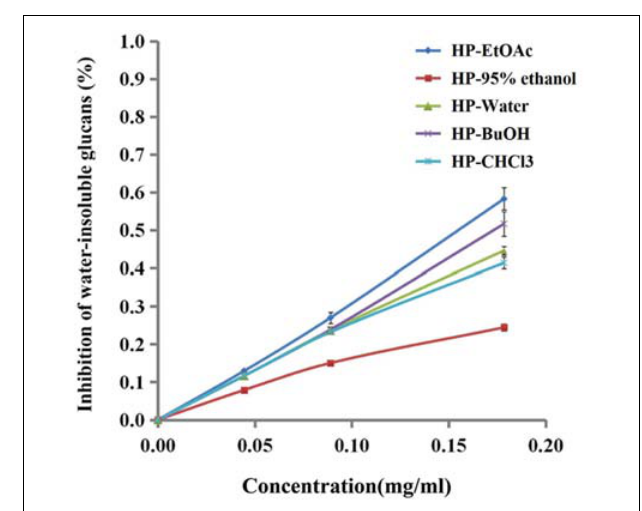
FIGURE 5 | Effect of B. crassifolia leaf extracts on water-insoluble glucan formation by Gtfs of S. mutans from sucrose. The formation of water-insoluble glucans was expressed as a percent of the control (without